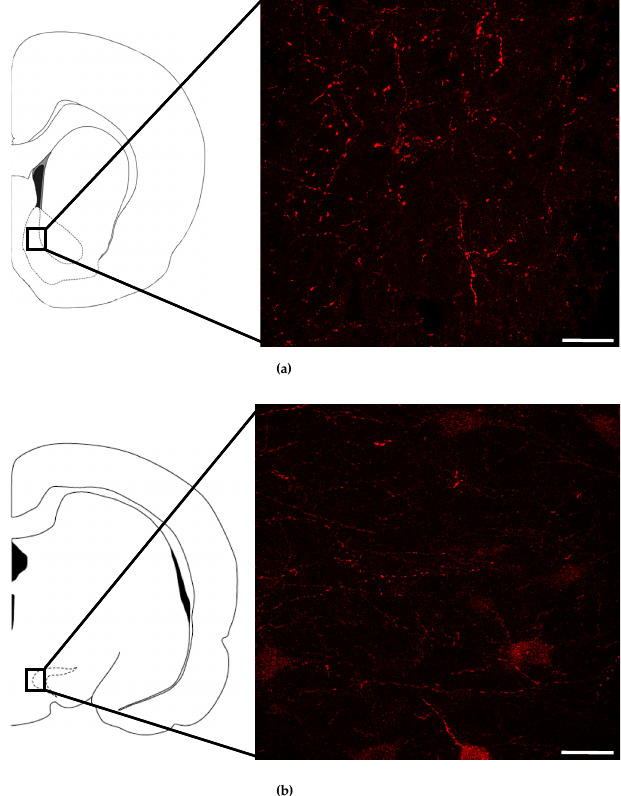
Figure 1. Neuropeptide receptor neuromedin U receptor 2 (NMUR2)immunostaining in the nucleus accumbens (NAc) and the ventral tegmental area (VTA). ( a ) Representative image of NMUR2 immunostaining in the NAc (bregma +1.92); ( b ) Representative image of NMUR2 immunostaining in the VTA (bregma − 4.80). Images were acquired from the regions indicated at in confocal mode, scale bar = 25 µ